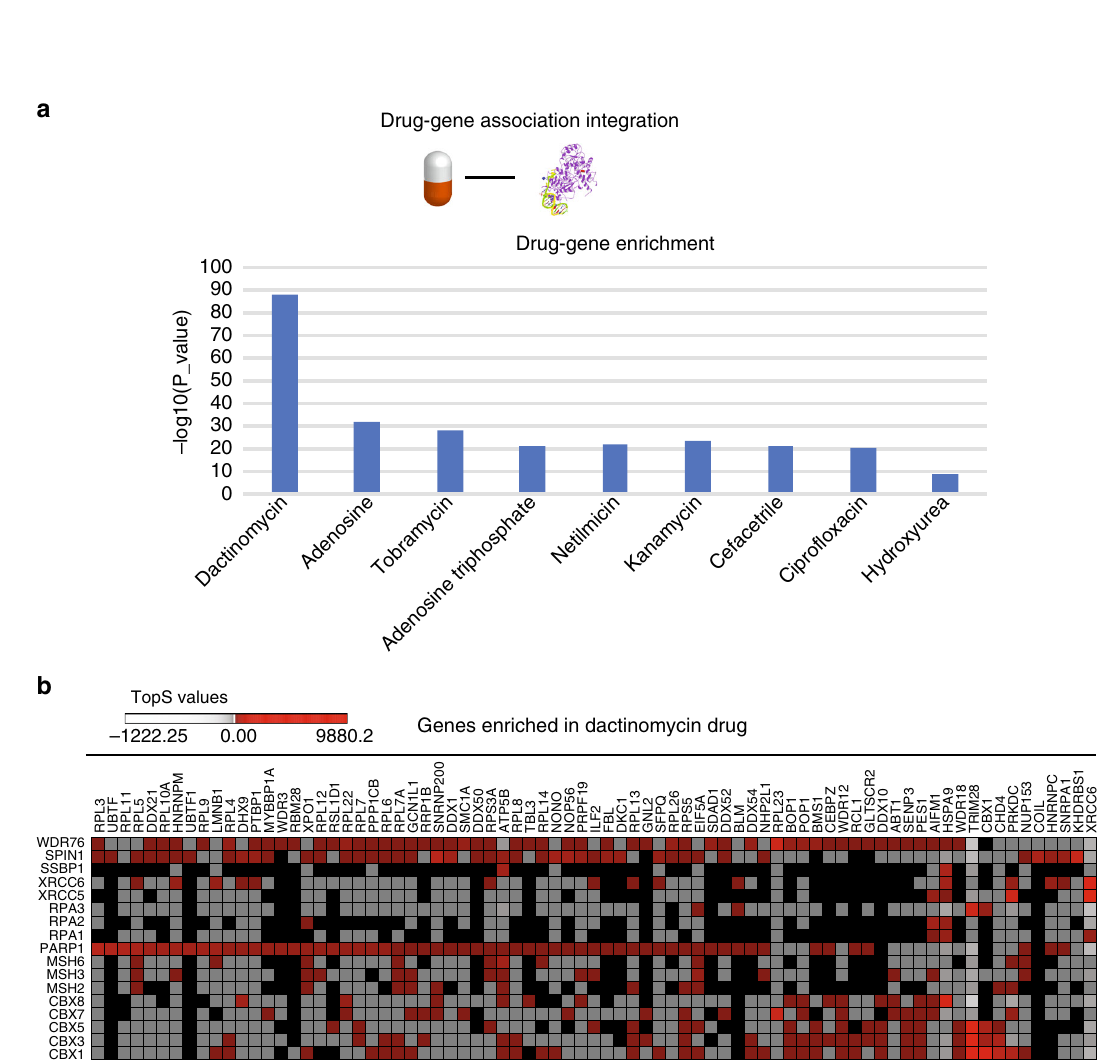
Fig. 3 Topological network and linkage analysis of a human DNA repair network. a TDA in combination with the TopS scores was applied to the proteins with Tops > 20 in at least one of the baits. Norm Correlation was used as a distance metric with two fi lter functions: Neighborhood lens 1 and Neighborhood lens 2. Resolution 30 and gain 3 were used here using the Ayasdi software 24 . Proteins are colored based on the rows per node. Color bar: red: high values, blue: low values. Node size is proportional to the number of proteins in the node. b A reduced network was created using information from the CRAPome 27 database, and the network was generated using Cytoscape platform 23 . Proteins associated with CBX1, CBX3, and CBX5 are expanded and highlighted in the inset. c Hierarchical biclustering using PermutMatrix 47 of protein with extreme positive TopS values. The 28 proteins with the highest TopS values across the dataset are shown. Rows and columns were clustered using Pearson as the distance and Ward linkage as the method. Yellow corresponds to high TopS values and gray shows negative TopS values. Proteins not present in the puri fi cations are shown in black. TopS